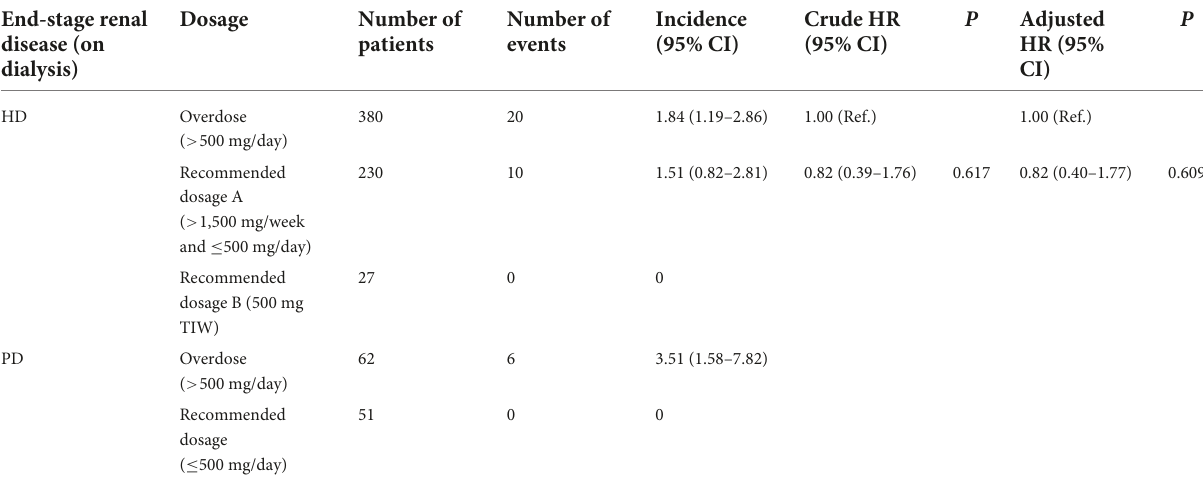
TABLE 3 Incidence (per 1,000 person-days) and risk of altered mental status among patients with end-stage renal disease on dialysis receiving different dosages of valacyclovir over a 30-day period. End-stage renal disease